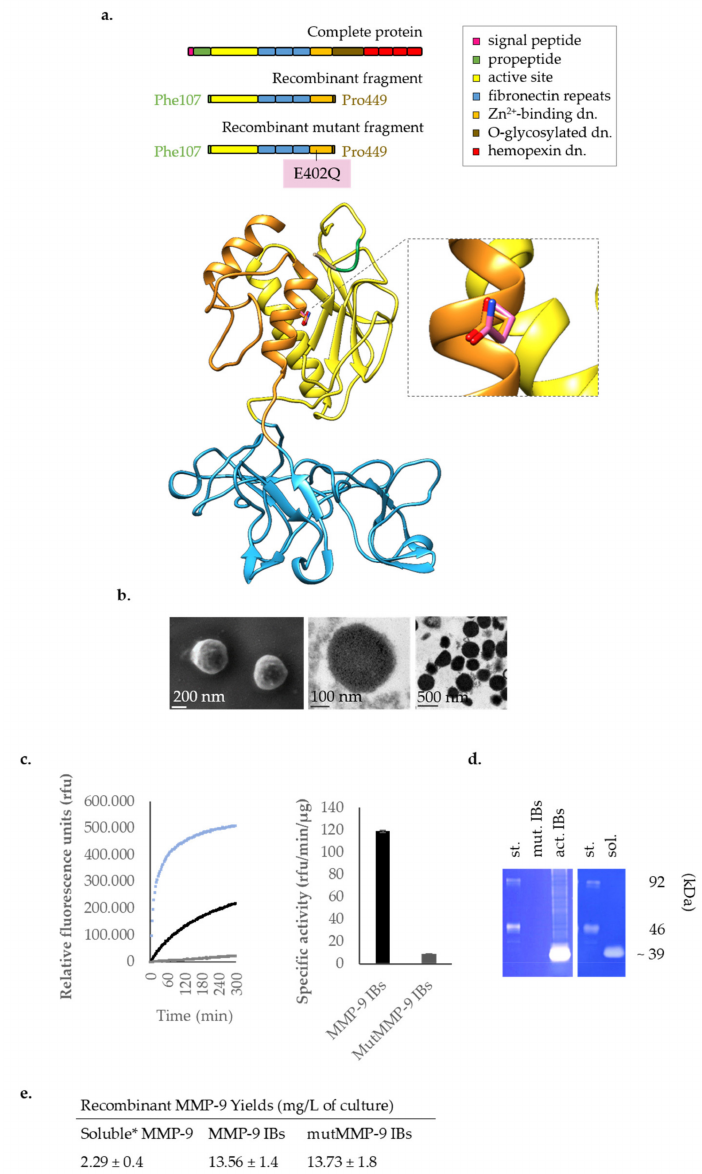
Figure 1. Recombinant MMP-9 and mutMMP-9 structures and functionality. ( a ) Recombinant bovine MMP-9. On top, domain ( dn. ) structure of the complete bovine MMP-9 compared with the recombinantly expressed protein fragment (Phe107–Pro449) and its proteolytic inactive mutant [25]. At the bottom, 3D model for P52176 (Phe107 to Gly444) with the mutated residue E402Q superposed (WT: Glutamic (E) colored in orange, mutant: Glutamine (Q) in purple). Left panel: full view of the generated models. Right panel: detail of the region with the mutated residue that impairs functionality in the mutMMP-9. ( b ) SEM (left) and TEM (middle and right) images of the MMP-9 IBs obtained from L. lactis . Recombinant MMP-9 and mutMMP-9 structures and functionality. ( c ) Degradation kinetics for MMP-9 IBs (black), MutMMP-9 IBs (grey), and the soluble MMP-9 (blue) (left) and the corresponding specific activity (SA) for the IBs (right). The soluble MMP-9 SA was 2,282.8 ± 21.9 rfu / min / µ g. Error bars indicate standard errors ( n = 3). ( d ) Zymography analysis showing that MMP-9 degrades gelatin in an electrophoresis gel. st. Standard MMP-9 mixture as the marker (see Section 2.8 for details); mut. IBs. Mutant MMP-9 IBs; act. IBs. Active MMP-9 IBs; sol. Soluble MMP-9; kDa. kiloDalton. ( e ) Recombinant MMP-9 yields either for soluble and IB forms; * Yield for peak 1 in the chromatography of the solubilized MMP-9; total soluble MMP-9 yield was 4.89 ± 2.8 mg / L of